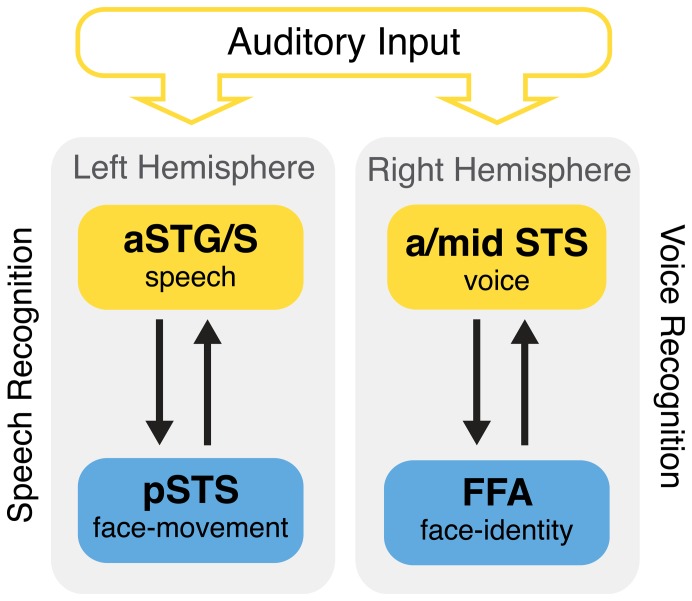
Hypotheses.Visual information about a speaker is integrated into the auditory analysis via functional connections (black arrows) between face-sensitive regions (blue) and higher-level auditory regions (yellow). Previous studies have shown that, during voice recognition, functional connectivity increases between the face-identity sensitive FFA and the voice-sensitive anterior/mid STS in the right temporal lobe (right side of the figure) (von Kriegstein and Giraud, 2006). In the present study, we tested whether, during speech recognition, functional interactions exist between the face-movement sensitive pSTS and speech-intelligibility sensitive areas in the aSTG/S in the left temporal lobe. In addition, we tested whether the integration of visual information into auditory information relies on the ability to recognize faces, by comparing a group of developmental prosopagnosics (i.e., people with a face-recognition deficit) with a group of normal participants. aSTG/S: anterior superior temporal gyrus/sulcus.